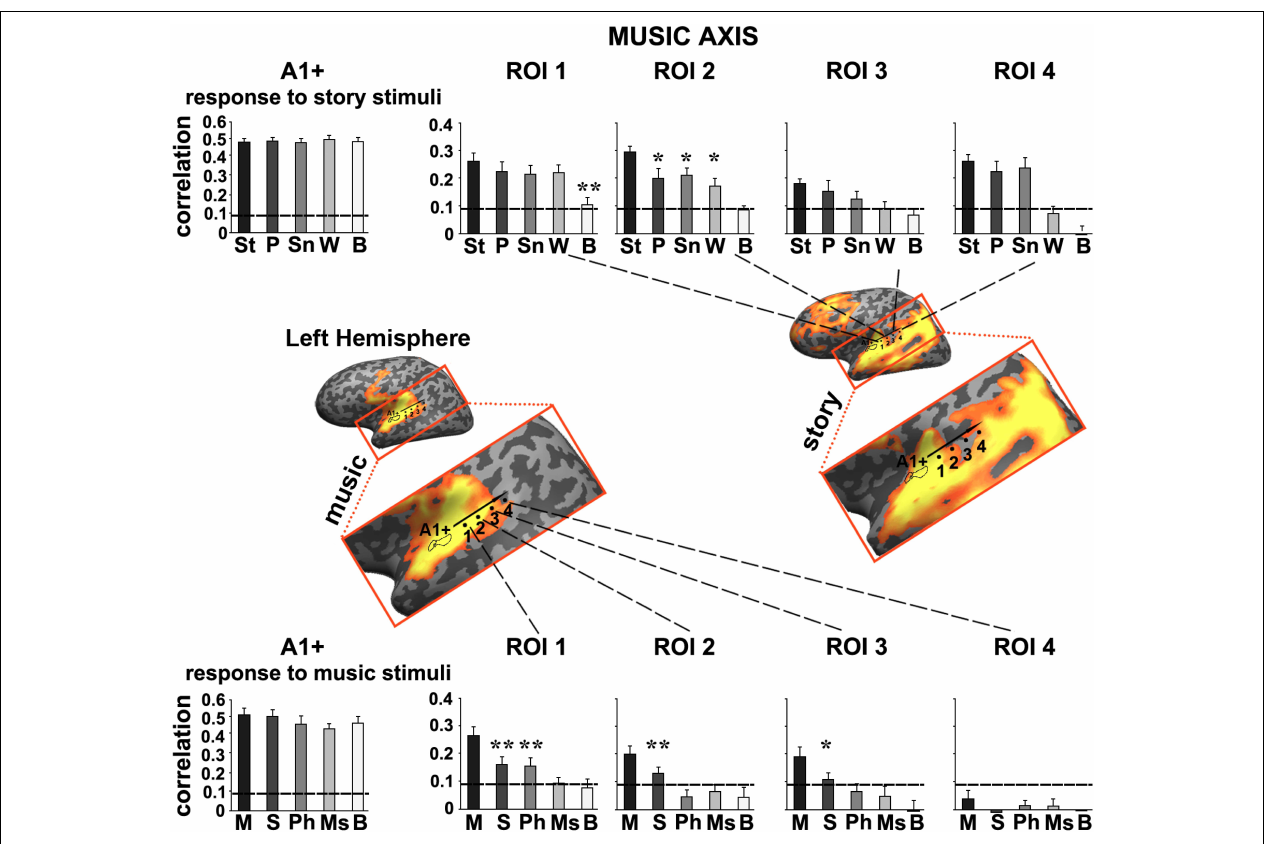
FIGURE 5 | Response reliability in ROIs defined along a “music axis” in the left hemisphere. Same format as Figure 4 except that the ROIs were evenly spaced along the music axis, which was manually defined along the map of reliable responses to the intact music stimulus.